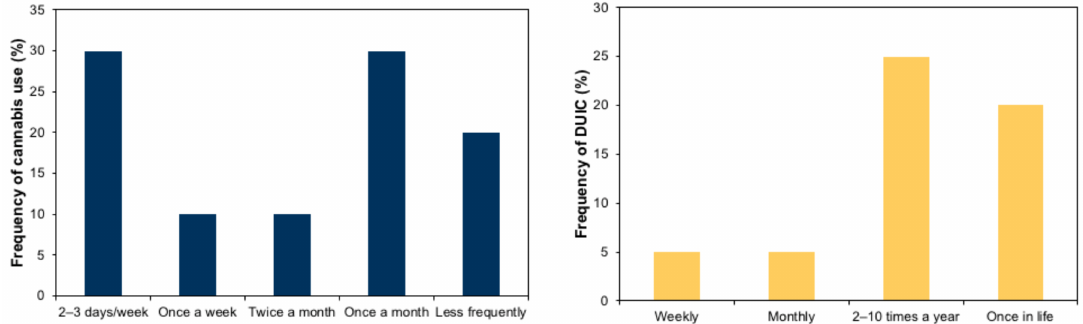
Figure 1. Self-reported frequency of cannabis use during the last six months (left) and self-reported frequency of DUIC (right) among the participants of the study.